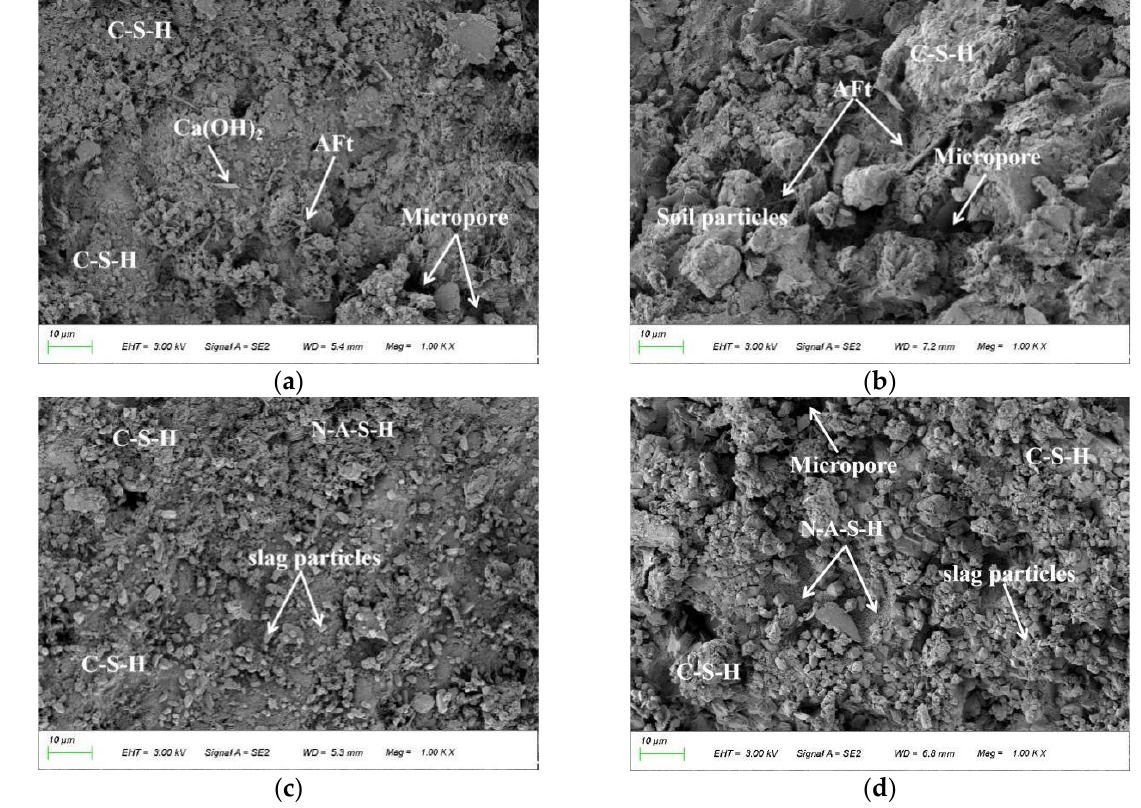
Figure 7. SEM images of stabilized soil immersed in sulfate erosion solution: ( a ) C0 (0 d); ( b ) C0 (60 d); ( c ) G-2 (0 d); ( d ) G-2 (60 d).